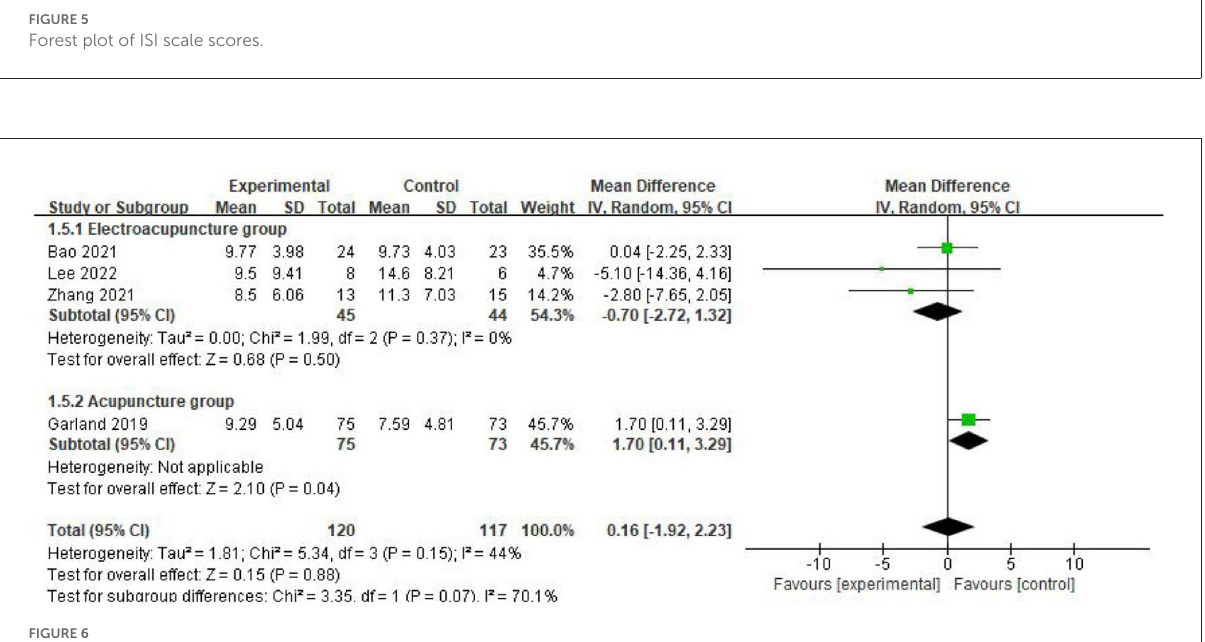
FIGURE6 Subgroup analysis of ISI